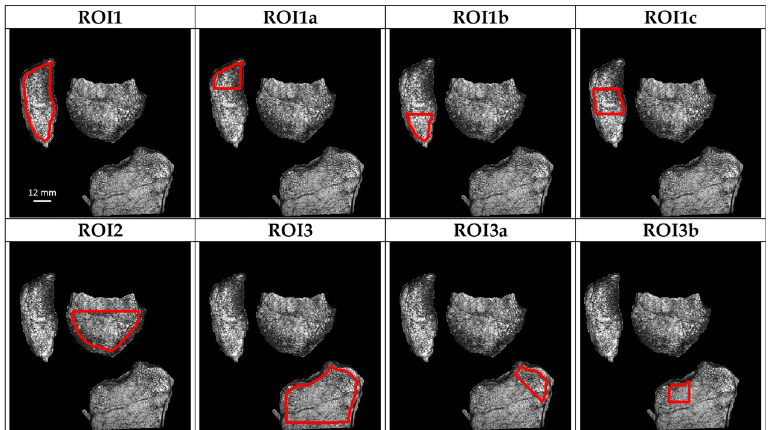
Fig 2. ROIs identification. PsA patient after treatment BVF maps showing the multiple ROIs identified in red.